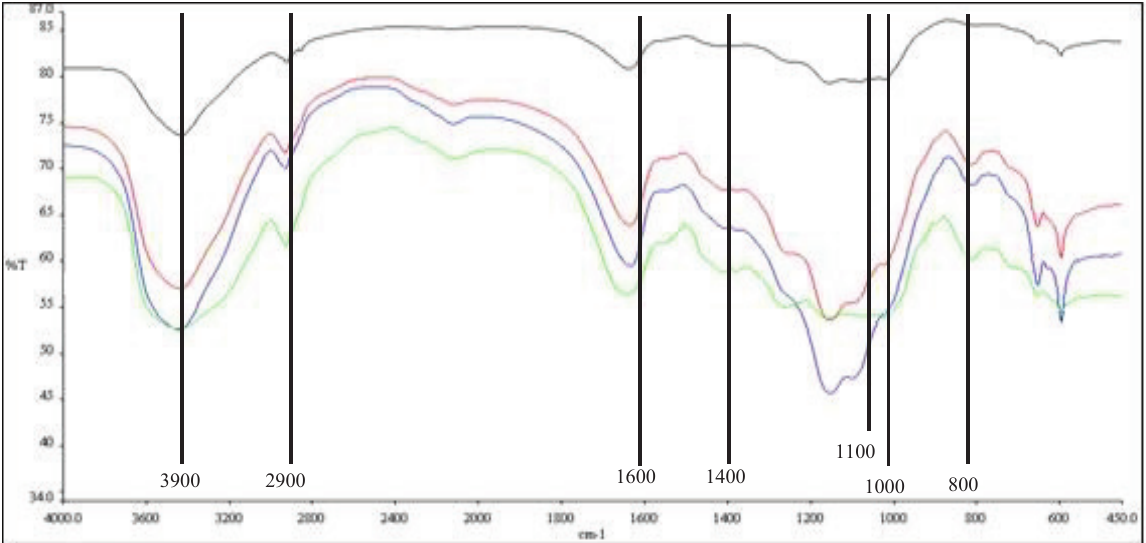
Figure 3. FTIR spectra of polysaccharides C. lentillifera; the black band (crude extract); green band (FP1 part); red band (FP2 part); blue band (FP3 part).